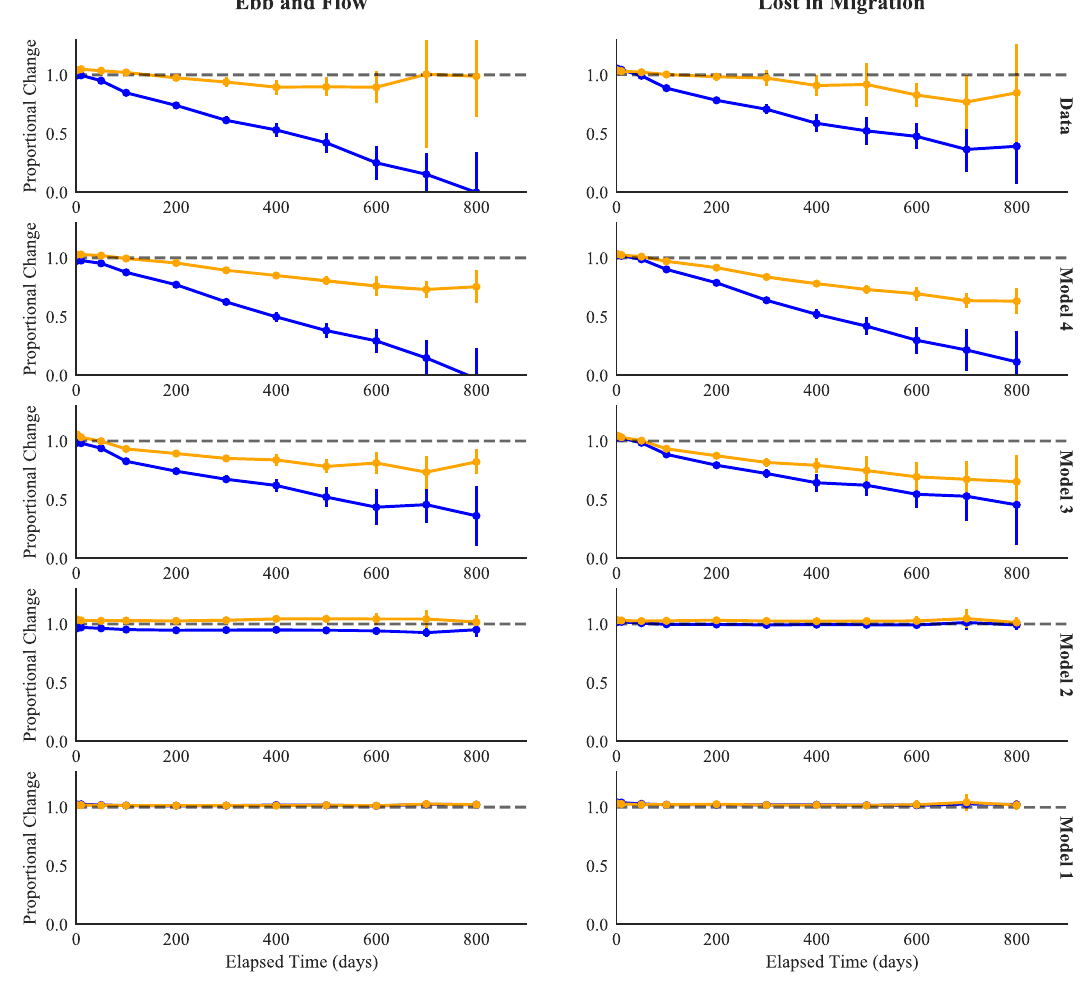
Fig. 6 Retention of performance as a function of delay between sessions. Results are shown for Lost in Migration and Ebb and Flow. Retention is assessed by the proportional change in performance relative to baseline. A value of one (dashed line) indicates no performance loss relative to the last gameplay in the previous session. Results are separated by the fi rst and second gameplay in the session after the retention interval. The error bars are the 95% con fi dence intervals of the